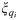
Flowchart of the PhyQuart algorithm.Simplified flowchart showing a) each of the three possible quartet relationships for a set of 4 sequences (q1, q2, q3), b) the site-pattern classification of observed (Nobs) symmetric (ξqi) and asymmetric (σqi) support (τqi), c) the determination of plesiomorphic (old) split-supporting site-patterns given two different polarities of character transformation along the internal branch of each possible quartet tree, ρq1→ and ρq1←, and d) estimation of expected convergent split-supporting site-patterns (κq1→,κq1←) supporting quartet q1 in ML split pattern estimations using branch length and model optimization on constraint topologies of the other two possible quartet relationships (q2, q3).